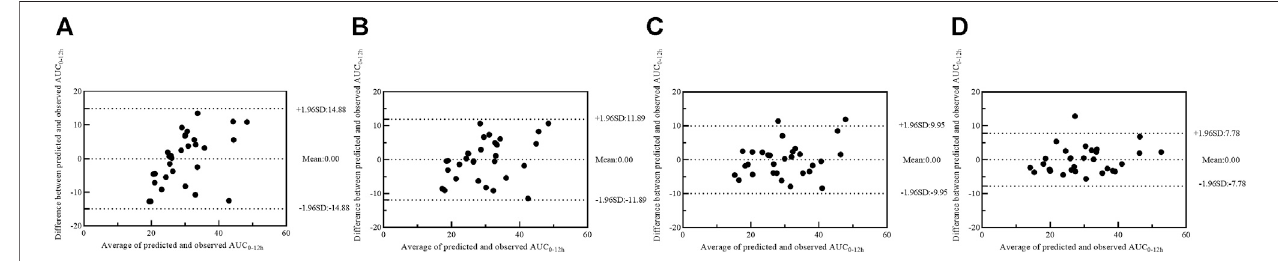
FIGURE 3 | Bland – Altman plot of differences between the observed AUC 0 – 12h and the predicted AUC 0 – 12h of MPA in model building group using model 1 (A) , model 2 (B) , model 3 (C) and model 4 (D) . AUC 0 – 12h , the area under the 12-h concentration-time curve; MPA, mycophenolic acid.